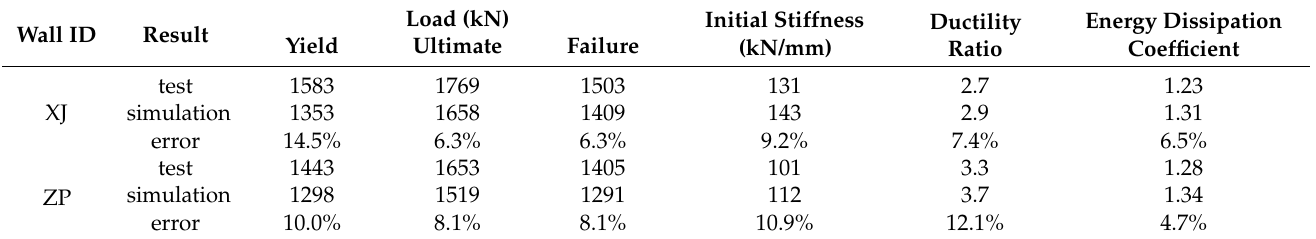
Table 7. Model characteristics. Model